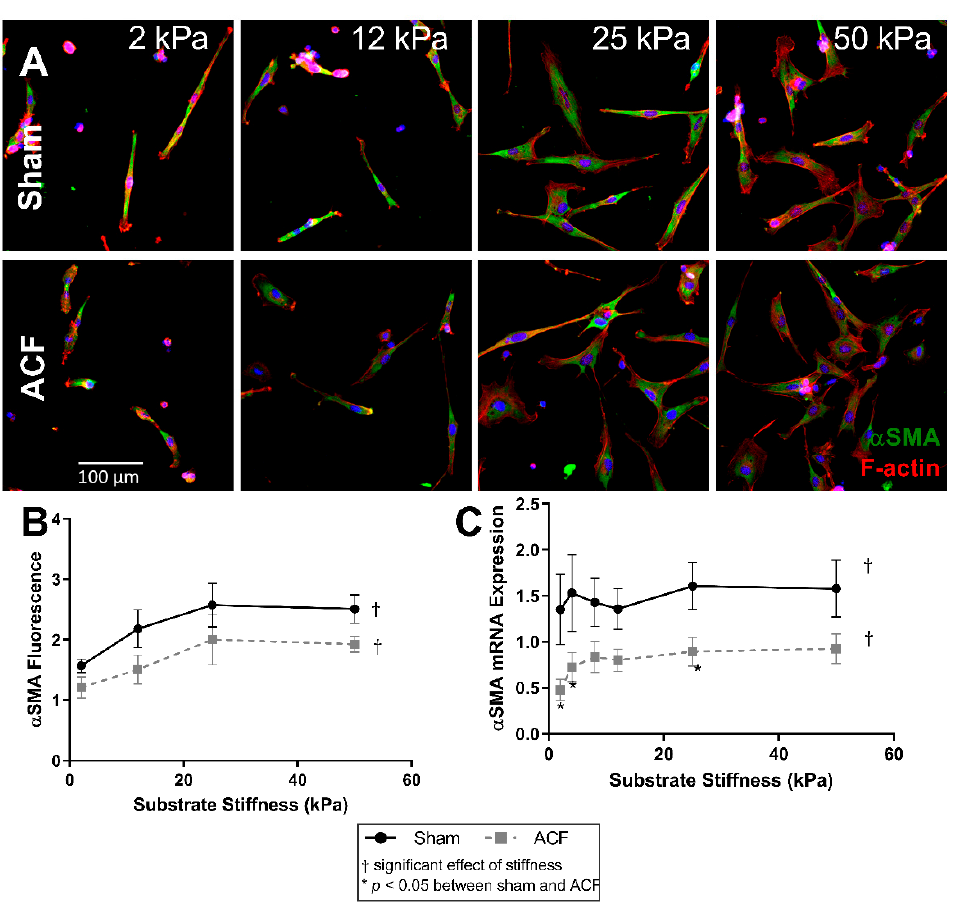
Figure 4. F-actin (red) and α SMA (green) fluorescent staining of sham and ACF ( A , B ) on different substrate stiffness. ( C ) α SMA mRNA expression increases with stiffness for both ACF and sham CFs, but ACF is generally lower overall. * indi- cates p < 0.05 when comparing sham vs. ACF. † indicates a signi fi cant e ff ect of substrate sti ff ness.